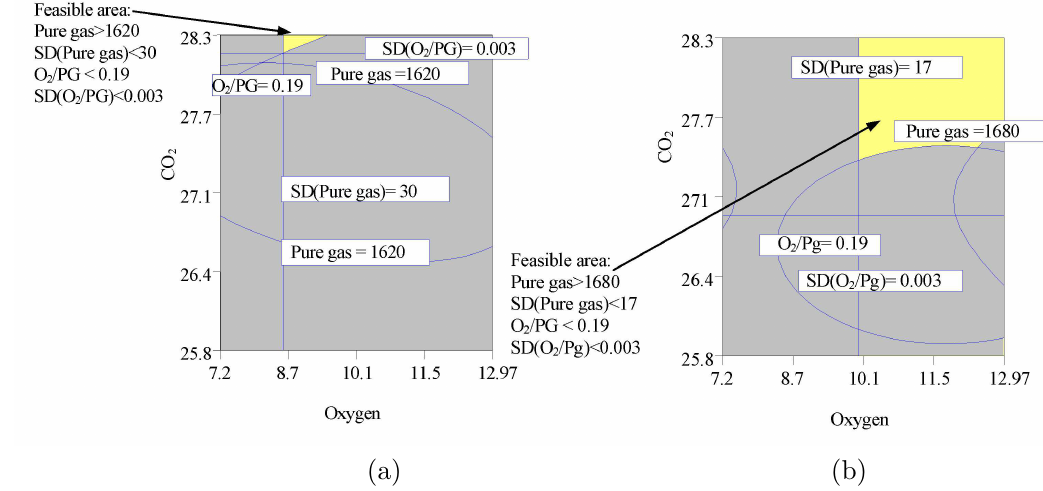
3 n/t DAF, ˆ σ ≤ c 2 m 3 n/t PG ( y ( x, w, z = 10)) ≥ c 1 m PG | z ≤ c 4 m 3 n/m 3 n simultaneously: | z